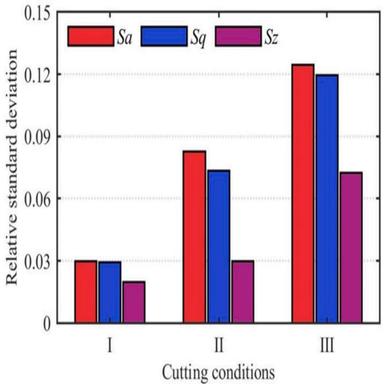
The relative standard deviation of surface texture parameters at different machining conditions of.